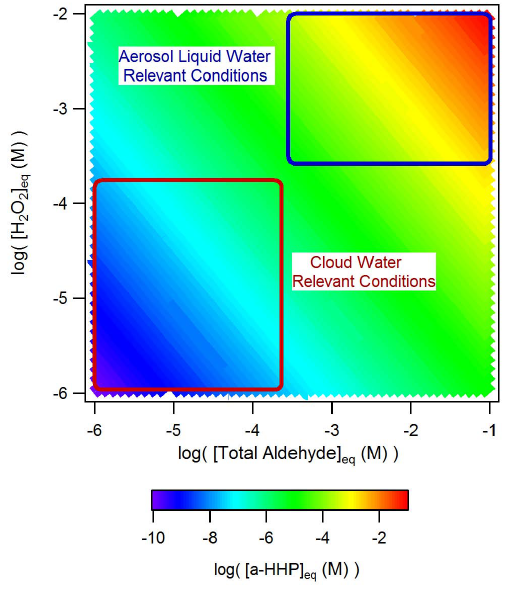
Fig. 8. Simulation of the equilibrium concentration of α - hydroxyhydroperoxide ([ α -HHP] eq ) arising from various equilib- rium concentrations of H 2 O 2 ([H 2 O 2 ] eq ) and total aldehyde ([To- tal Aldehyde] eq ) . The concentrations are all presented in log scale. Conditions relevant to cloud water and aerosol water are also indi- cated. This simulation considers α -HHP formation via only the car- bonyl pathway, with an average equilibrium constant of 100 M − 1 .